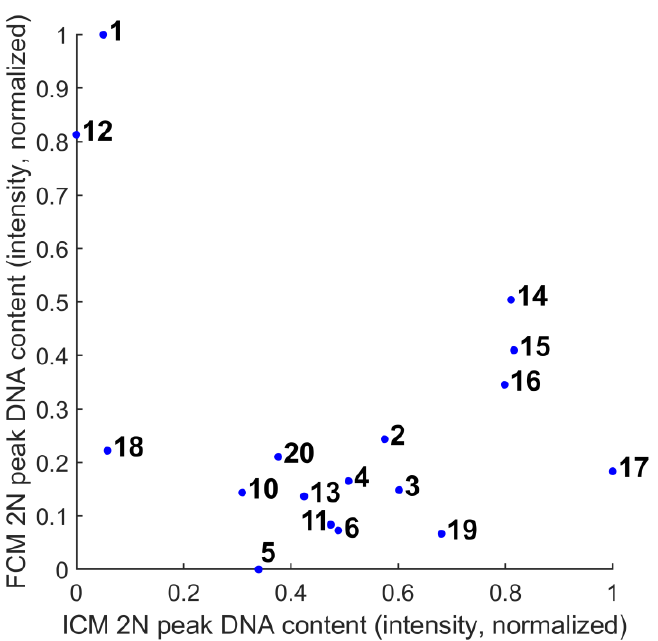
Figure 15. The DNA content of the first peaks of the samples (as a very rough approximation of the image intensity), the data points labeled with the sample indices. Samples #1, #12, and #18 are of lower intensity than the other samples. This is probably due to extended exposure to excitation light during multiple attempts to select the digitization parameters. These samples were treated as outliers for the rest of the process. Samples #7, #8, and #9 were not digitized in the expected quality (unfocused), and were omitted from the study altogether.